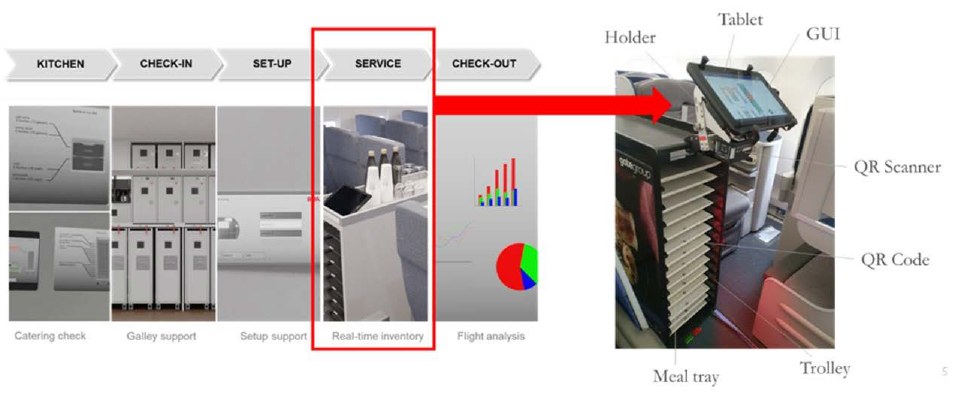
Figure 16. Concept demonstration for inflight meal individualisation.